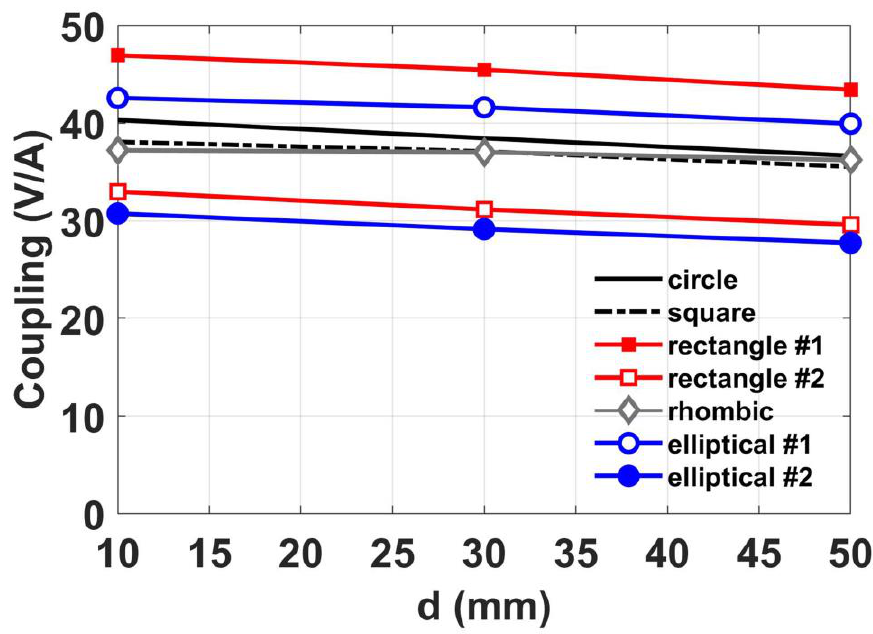
Figure 4. Coupling performance of each antenna.